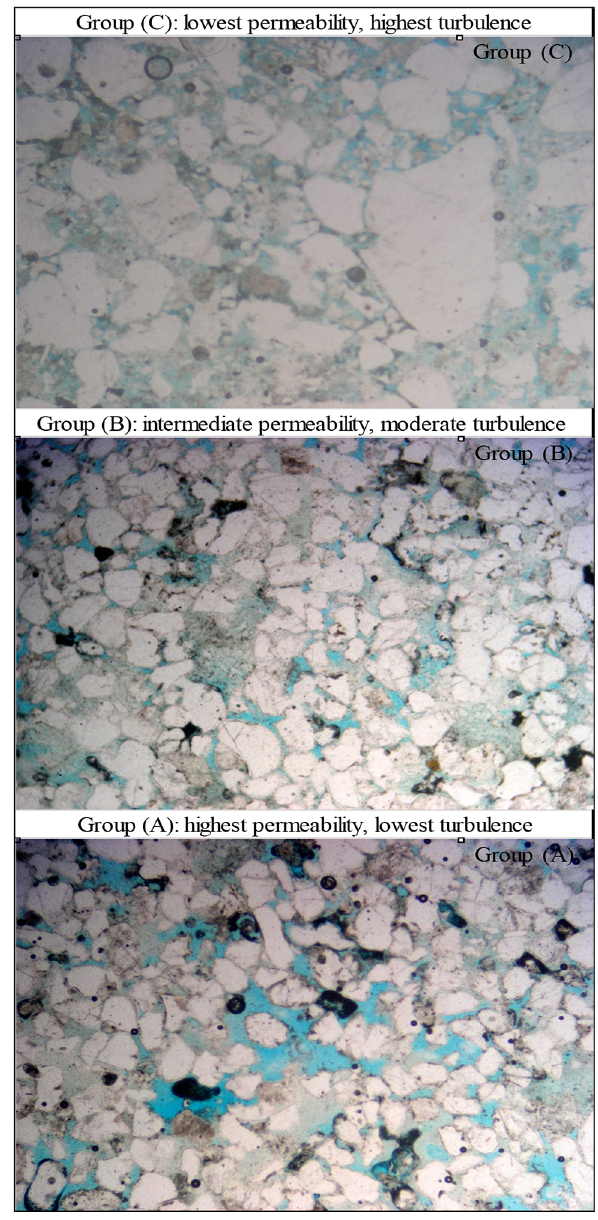
Fig. 13 Photomicrograph displaying the distinctive pore system for each group of the three